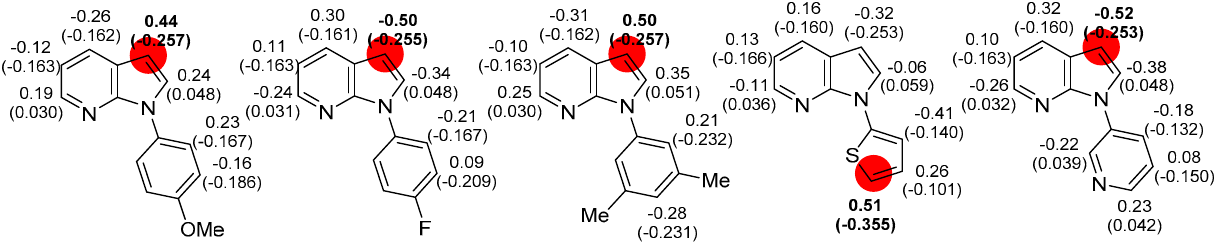
Figure 9. Calculated C charges (in brackets) and HOMO coefficients obtained by using the HuLiS calculator [73] for 7-azaindole, 1-phenylindole and 1-phenyl-7-azaindole ( 1a ).